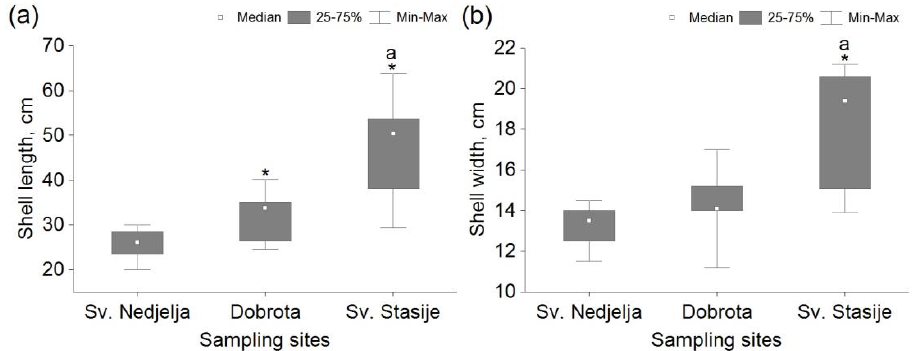
Figure 4. Antero – posterior shell length ( a ) and width ( b ) of Pinna nobilis sampled from Sv. Nedjelja (n = 12), Dobrota (n = 9) and Sv. Stasije (n = 7) within the Boka Kotorska Bay. *—statistically significant difference ( p < 0.05) in comparison with the reference site (Sv. Nedjelja); a—statistically significant difference ( p < 0.05) in comparison with the other sampling site; n — number of specimens. Mean Hr rest was significantly higher in mussels from Dobrota in comparison to other sites, while mussels from Sv. Stasije showed a significantly lower value of mean Hr rest in comparison to Sv. Nedjelja (Figure 5a). There was no significant difference in T rec between the specimens from the Dobrota and Sv. Stasije sites, however specimens from both sites showed significantly longer T rec in comparison to Sv. Nedjelja (Figure 5b). Figure 5. ( a ) — resting heart rate (Hr rest ); ( b ) — heart rate recovery time (T rec ) within a group of Pinna nobilis specimens sampled from Sv. Nedjelja, Dobrota and Sv. Stasije. * — statistically significant difference ( p < 0.05) in comparison with the reference site (Sv. Nedjelja); a — statistically significant difference ( p < 0.05) in comparison with the other sampling site. Furthermore, a significant correlation ( p < 0.05) was observed between the data for T rec and shell length ( p = 0.000528; r = 0.59; Figure 6a), and T rec and shell width ( p = 0.0000875; r = 0.65; Figure 6b). On the other hand, in comparison between Hr rest and shell length, a significant correlation was not observed ( p = 0.029318; r = − 0.36; Figure S2a), nor between Hr rest and shell width ( p = 0.033571; r = − 0.35; Figure S2b).